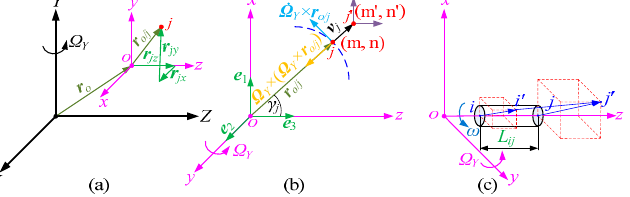
Figure 17. Relative motion: ( a ) displacement vector of node j ; ( b ) convected acceleration vector and Coriolis acceleration vector; ( c ) rotational angular velocity.